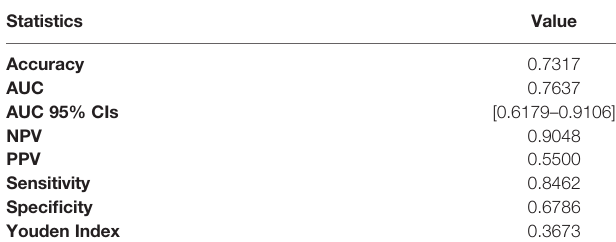
TABLE 3 | ROC analysis of ADC radiomics